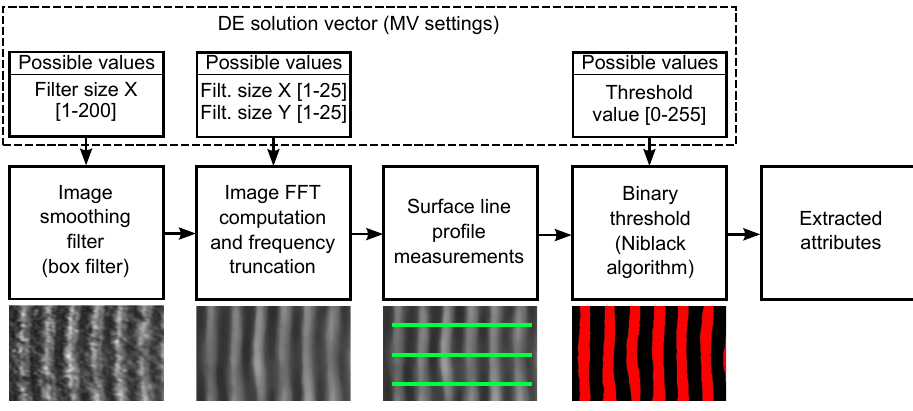
Figure 6. The attribute extraction